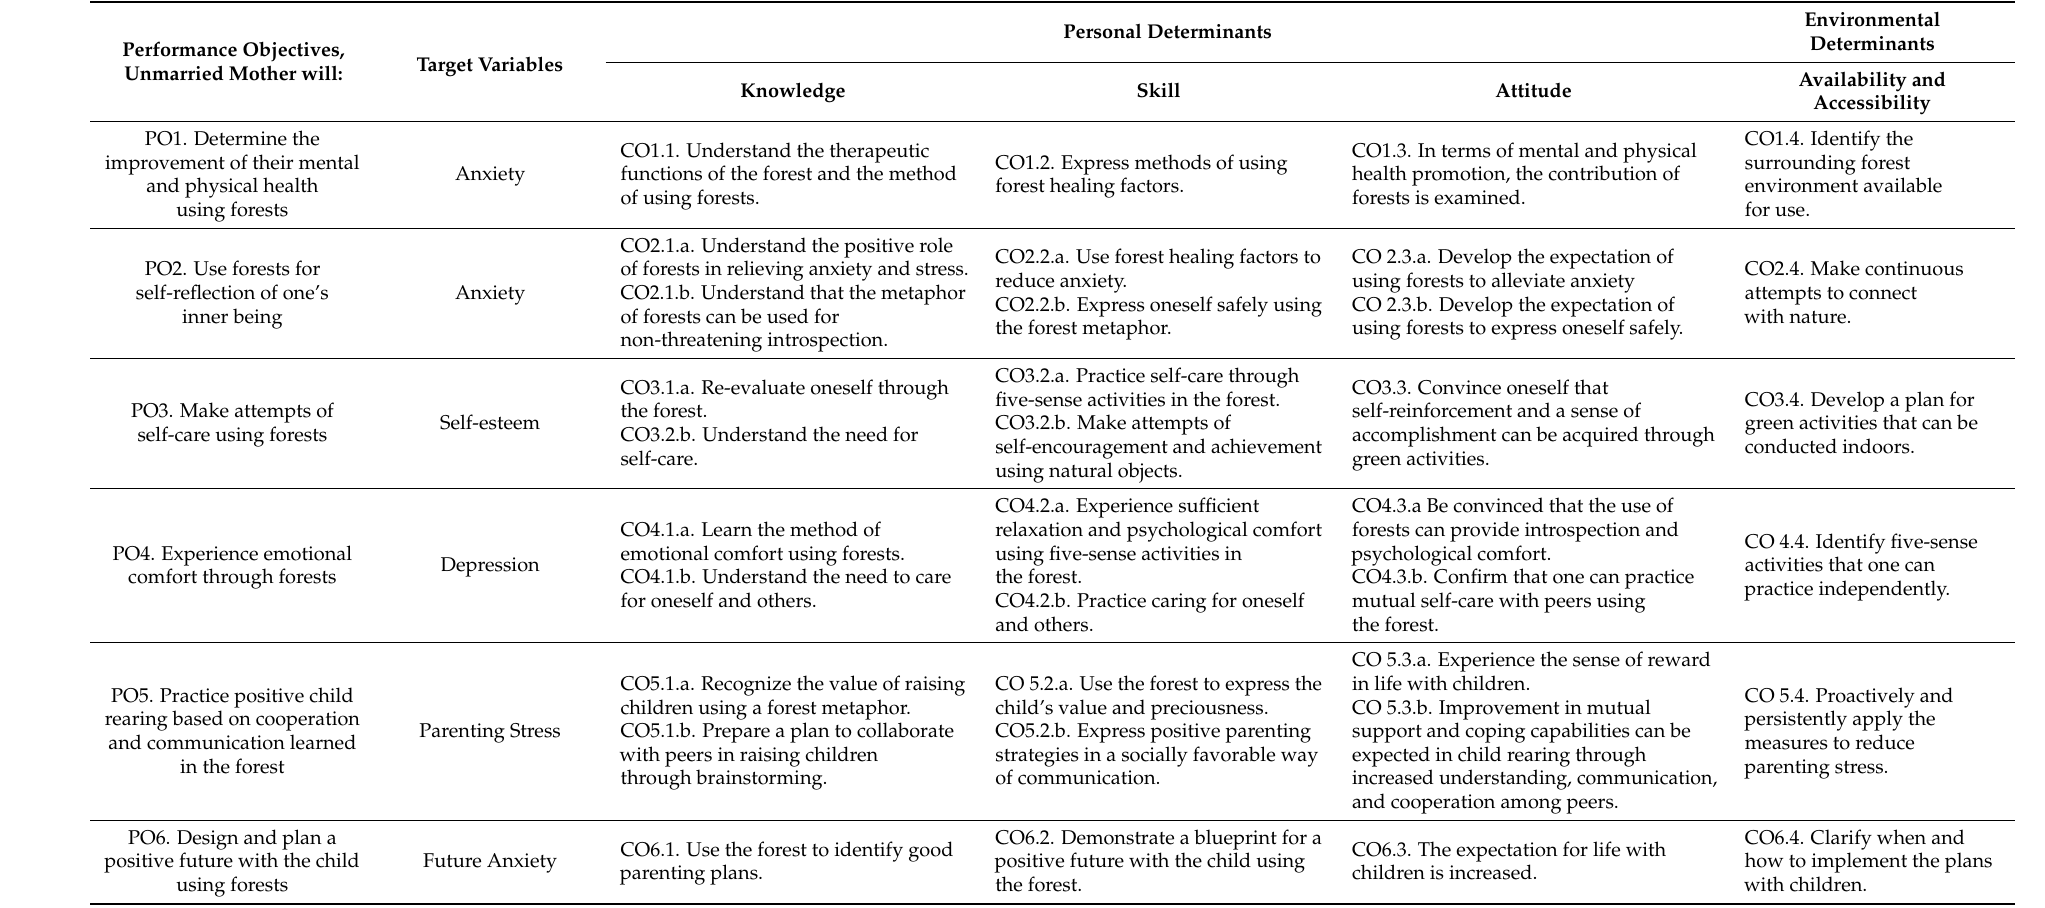
Table 3. Matrix of the Urban Forest Program for Unmarried